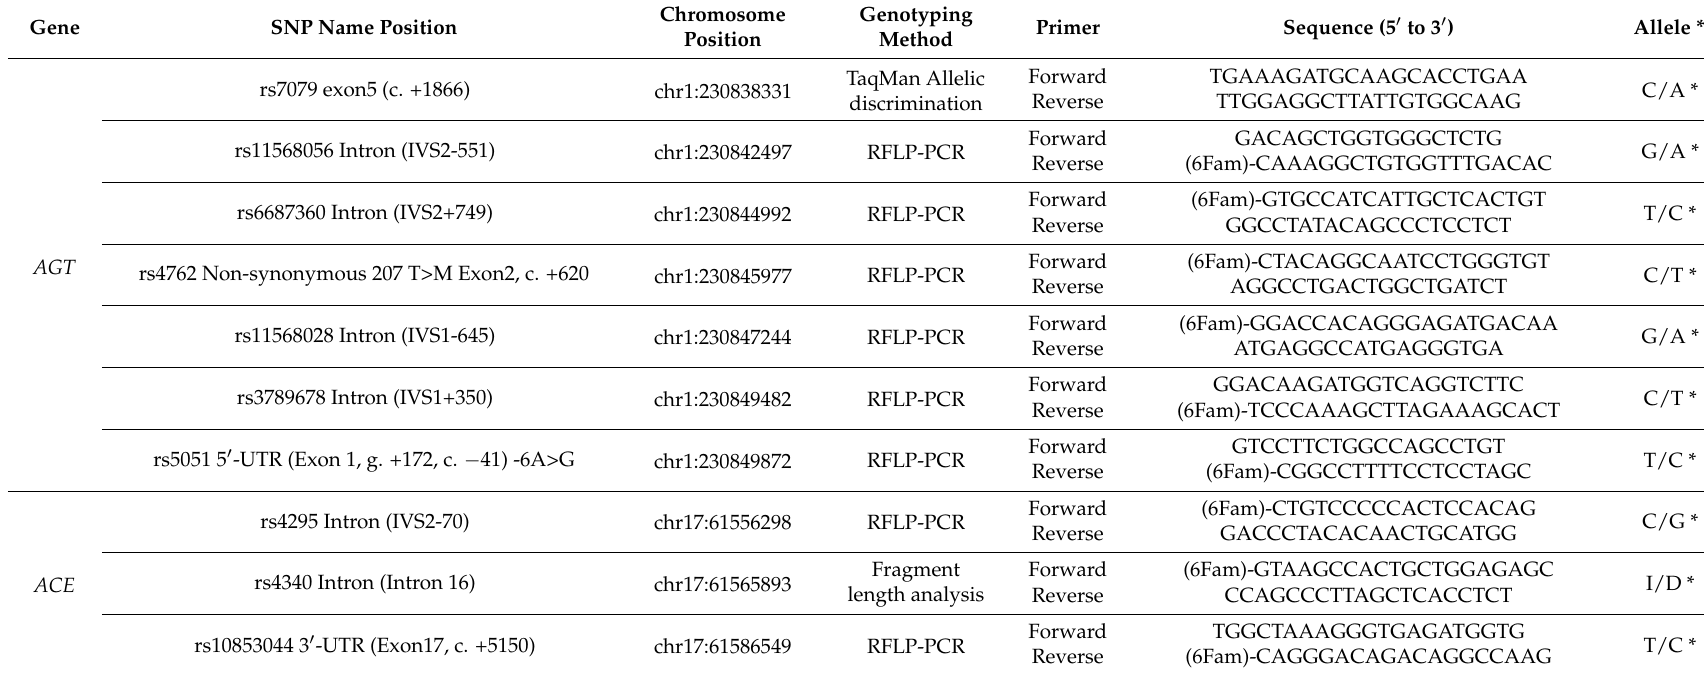
Table 2. Primer sequences and PCR conditions for amplification of polymorphisms within renin-angiotensin-aldosterone system-related